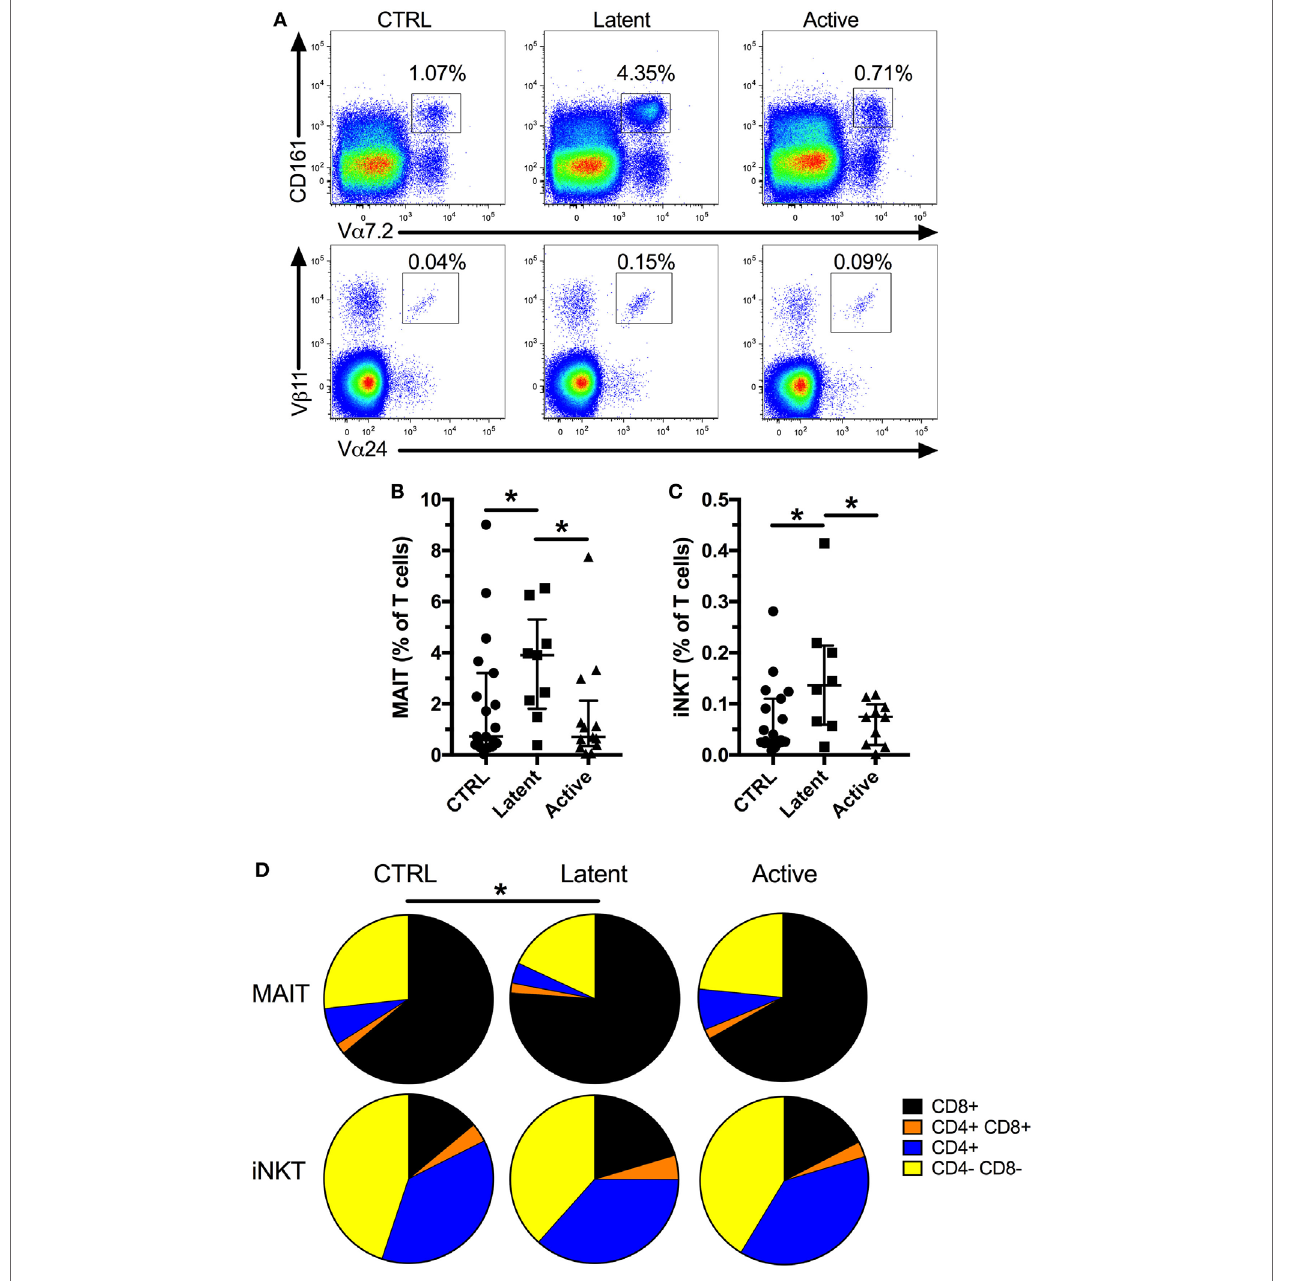
FigUre 1 | Mucosal-associated invariant T (MAIT) and invariant natural killer T (iNKT) cells are increased in subjects with latent Mycobacterium tuberculosis (Mtb infection). Representative flow plots showing MAIT and iNKT cell frequencies (a) . Frequency of MAIT cells in controls ( n = 19), latent Mtb ( n = 9), and subjects with active Mtb infection ( n = 13) (b) . Frequency of iNKT cells in controls ( n = 19), latent Mtb ( n = 8), and subjects with active Mtb infection ( n = 10) (c) . Proportion of CD8 + , CD4 + CD8 + , CD4 + , and CD4 − CD8 − cells in MAIT (top row) and iNKT cell (bottom row) for controls (left column), latent Mtb (middle column), and subjects with active Mtb infection (right column) (D) . The lines and whiskers represent the median and interquartile range, respectively (* p <